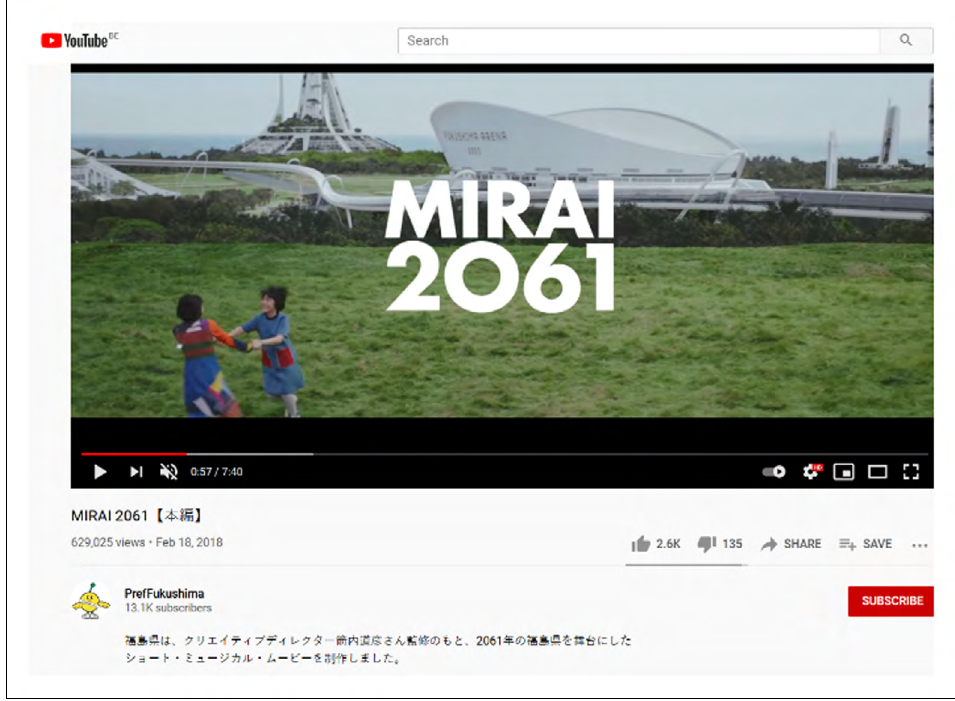
Figure 1 Screenshot of the musical video “Mirai 2061,” available at the Youtube channel of Fukushima Prefecture. Behind the two dancing main characters, futuristic buildings are displayed. Source: https://www.youtube.com/watch?v=mLOeF2pW978 (Last accessed 15 July 2021).